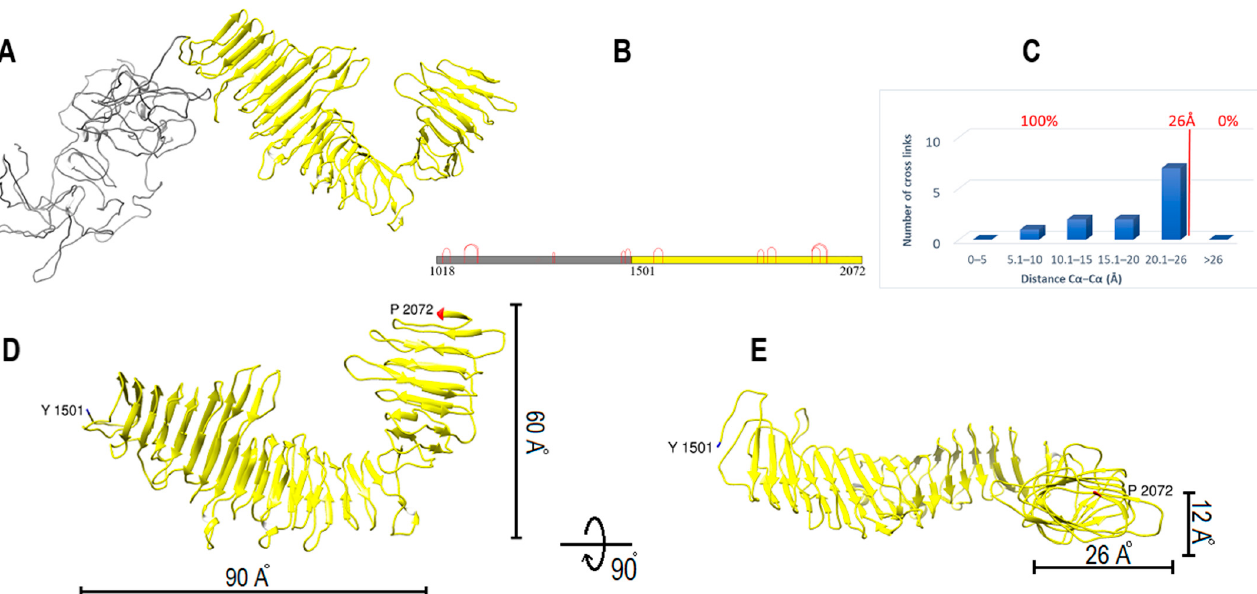
Figure 3. ApoB-100 subunit II structure and cross-link map. ( A ) Ribbon representation of ApoB-100 subunit II coil (gray) and domain 1 (yellow) with β -helix folding. ( B ) DSSO cross-link map on subunit II linear sequence colored according to A. ( C ) The distribution plot of identified DSSO cross-links in subunit II vs. the spatial distances of lysine residues in the computational model. ( D , E ) Ribbon representation of subunit II domain 1 shows a boomerang shape β -helix with 90 Å and 60 Å wings span followed by a 90° rotation representation. Coronal section of this domain shows an oval shape helix with 26 Å and 12 Å dimensions.